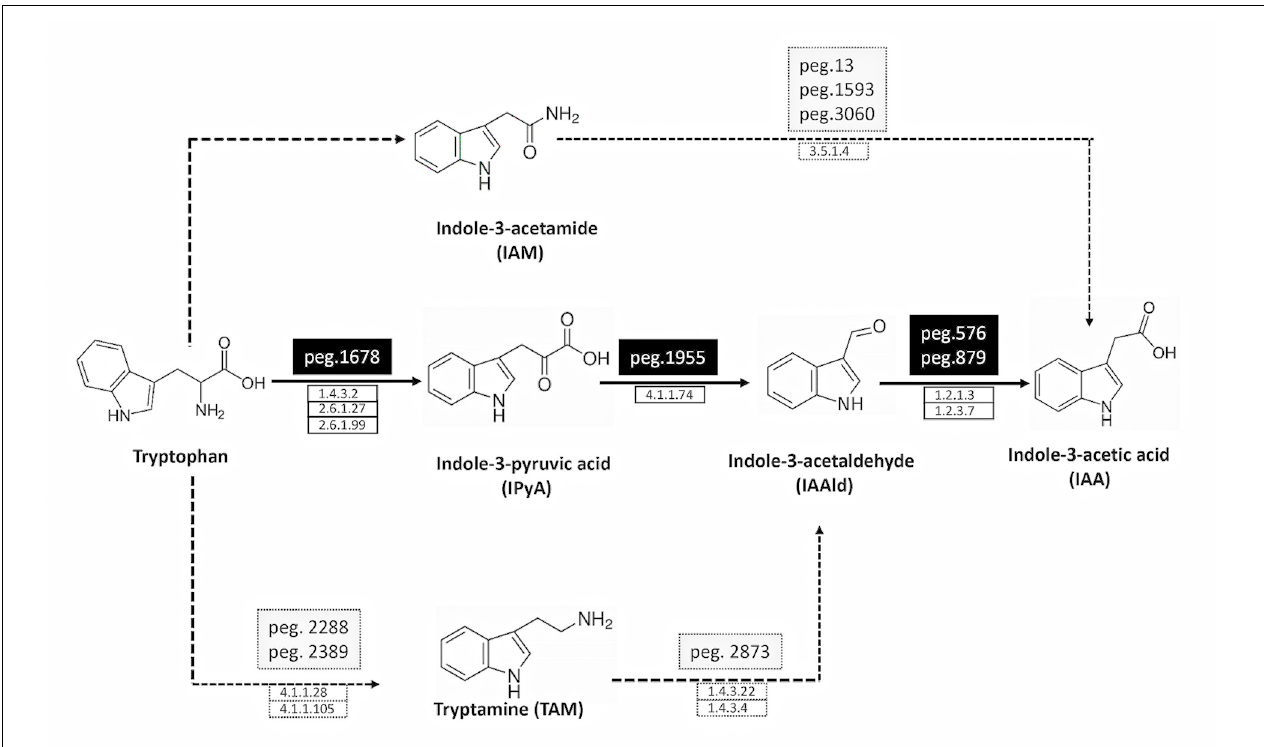
FIGURE 1 | Deduced pathways for IAA biosynthesis in P. agglomerans strain C1. The solid line indicates the principal pathway for IAA biosynthesis, and the dotted ones the pathways that are not fully supported by molecular evidences (low identity with known proteins; see Table 1 for details). The names of the pathways indicate the name of their first products. The names of the protein encoding genes (peg) and the definition of the protein coding enzymes (EC number) are reported on the top and the bottom of the arrows,